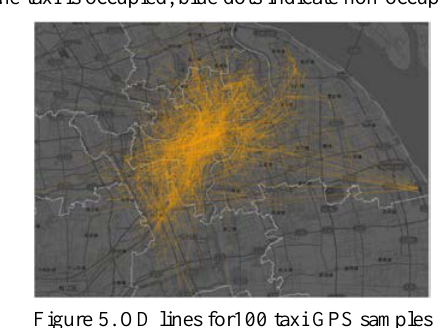
Figure 5. OD lines for100 taxi GPS samples